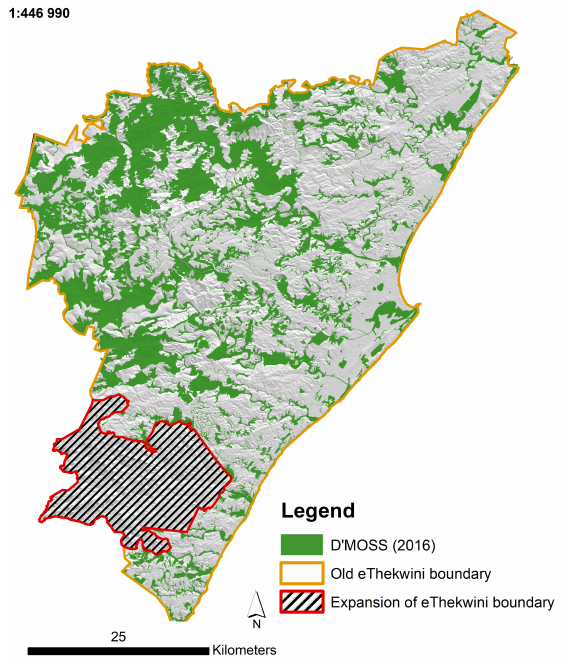
Fig. 3. Map of the Durban Metropolitan Open Space System